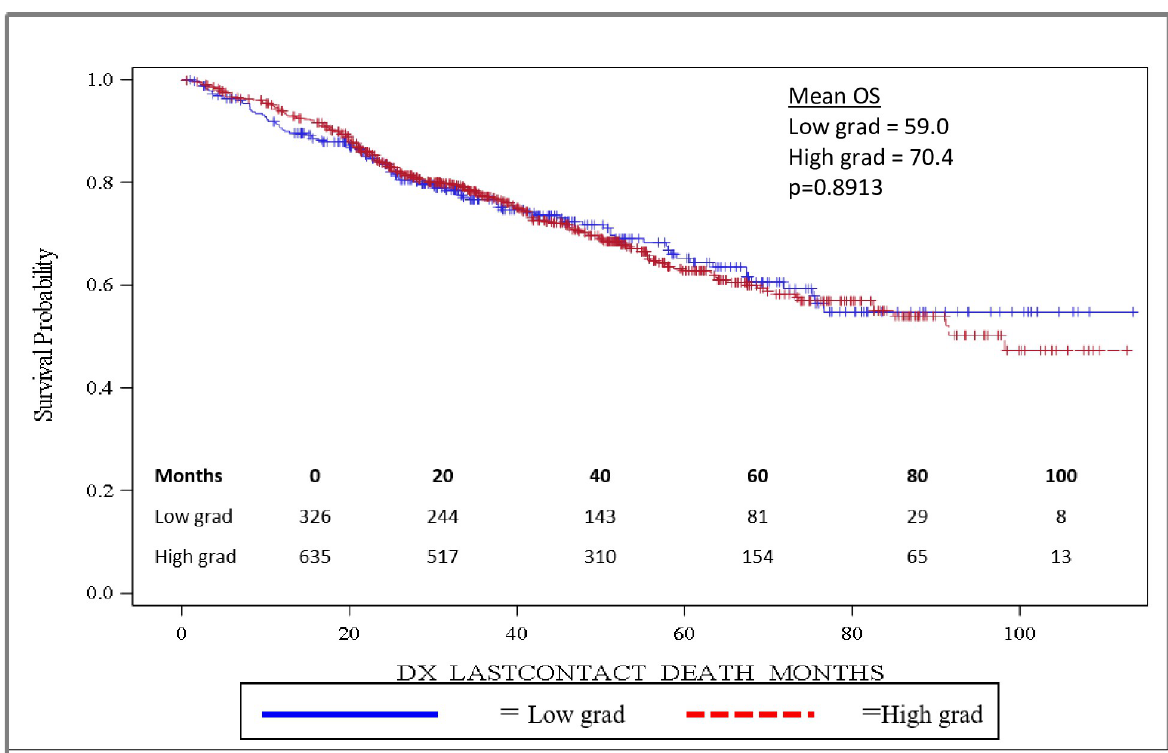
Fig 5. Overall survival based on high school